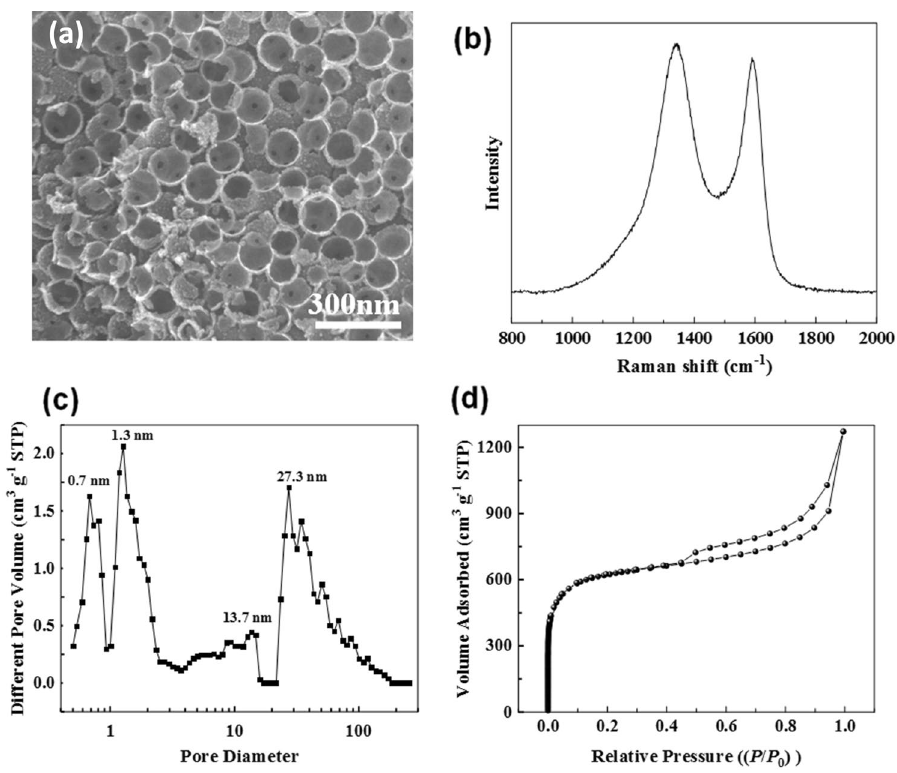
Figure 5. ( a ) SEM image, ( b ) Raman shift graph, ( c ) DFT pore size distribution and ( d ) N 2 adsorption– desorption isotherm of